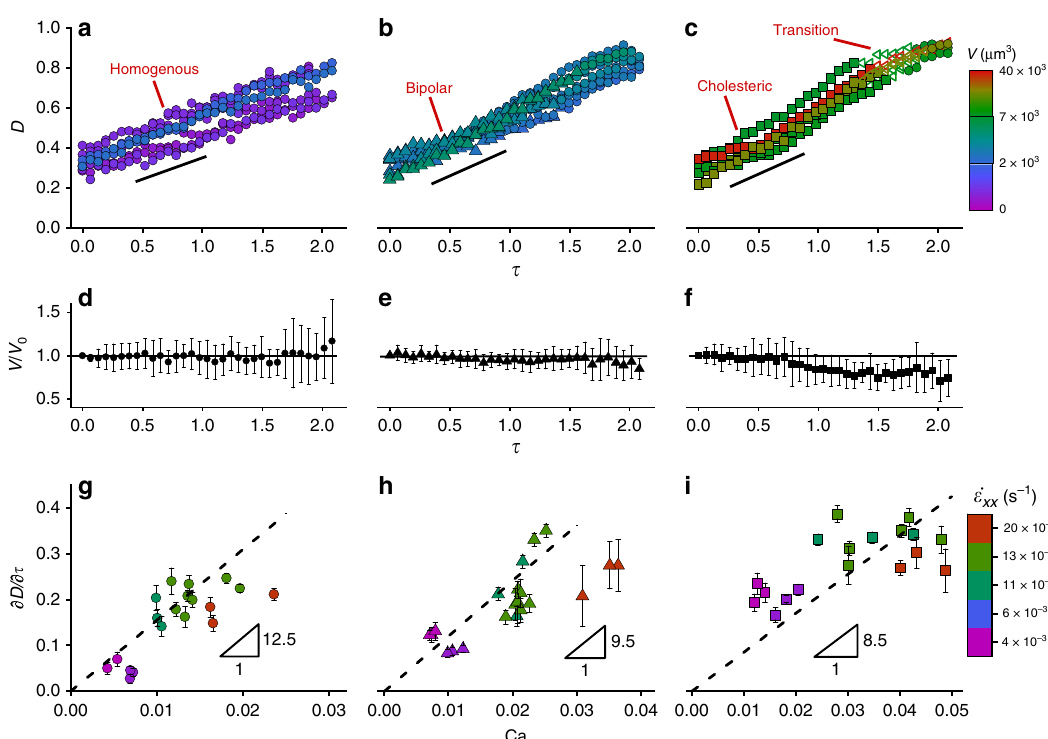
Fig. 3 Deformation of different classes of liquid crystalline tactoids. The data points presented by fi lled circle, triangle, and square correspond to homogenous, bipolar, and cholesteric tactoids, respectively. The empty symbols denote the transition regime of cholesteric to homogenous tactoids. a – c Deformation of tactoids under an extension rate of 0.013 s − 1 that shows a linear change in the deformation parameter D as a function of dimensionless time τ and order – order transitions of the bipolar and cholesteric tactoids to homogenous ones. d – f Variation in the volume of the tactoids under an extension rate of 0.013 s − 1 showing that the volume of the tactoids remains essentially constant. g – i The linear dependence of D on τ is tested for different Ca numbers. A linear fi tting is used, as suggested by simple fl uids theories. A total of 59 tactoids have been analyzed. The error bars in d – i denote standard